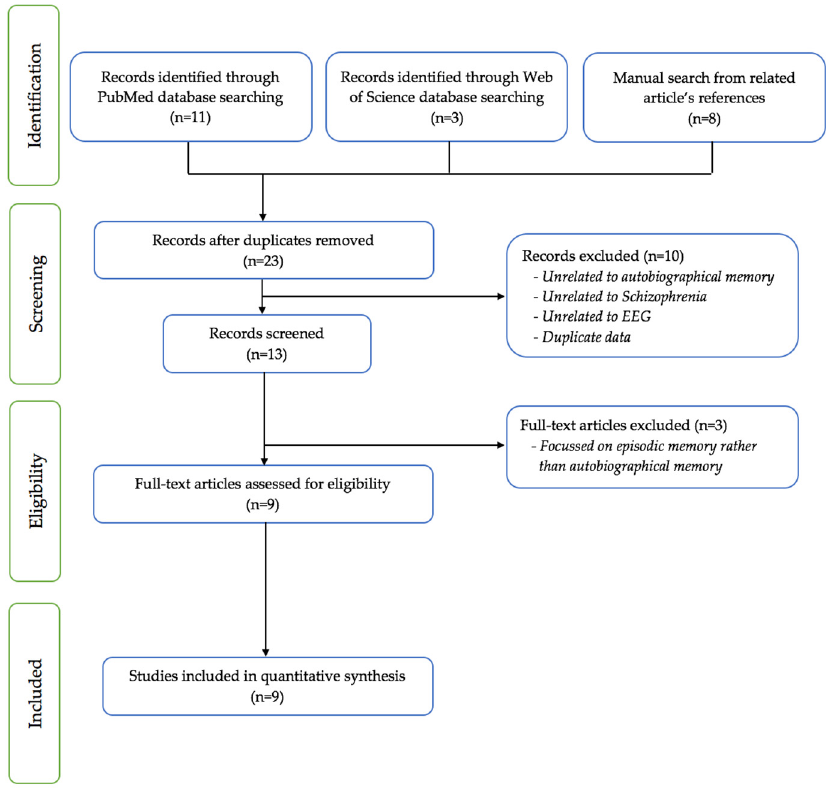
Figure 6. PRISMA study scheme related to autobiographical memory in patients with schizophrenia by means of EEG.